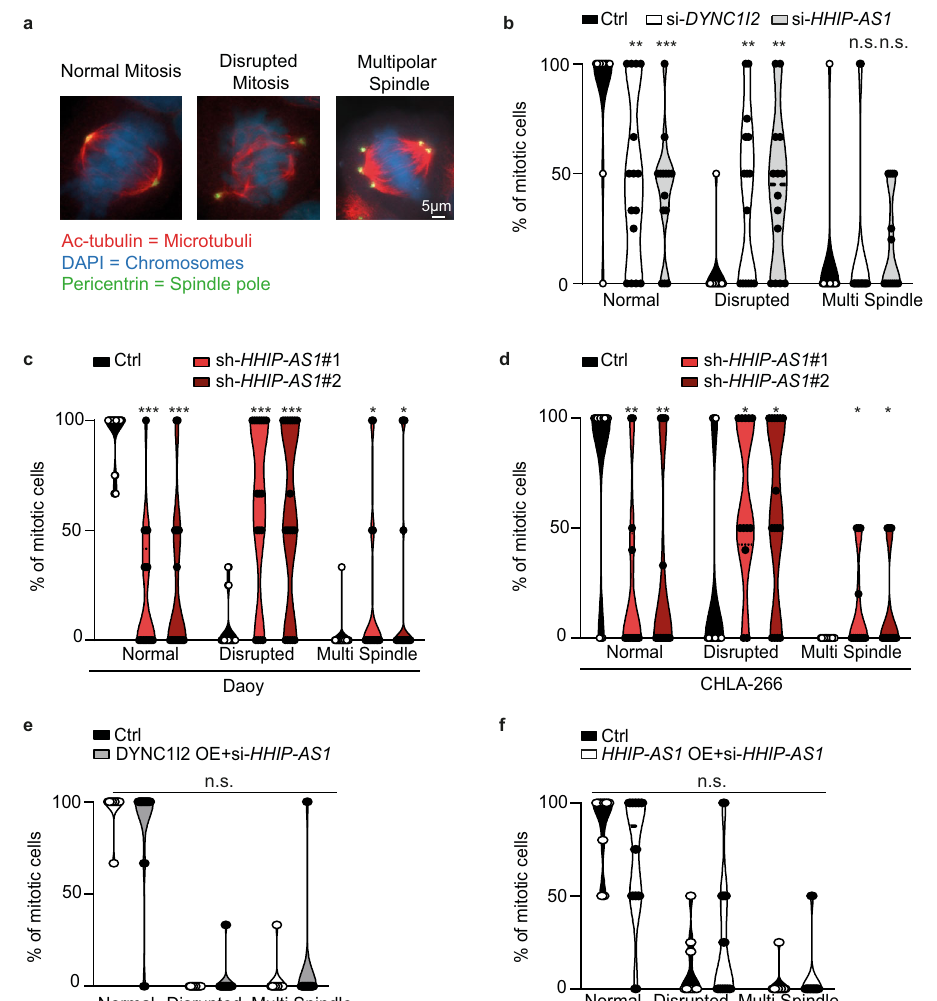
Fig. 4 The interaction between HHIP-AS1 and DYNC1I2 promotes mitosis. a Representative images of immuno fl uorescence analysis show spindle assembly in mitotic cells by immunostaining for acetylated tubulin (Ac-tubulin, red) and pericentrin (green). Chromosomes are visualized with DAPI (blue). White scale bar: 5 μ m. b – d Bar graphs display the percentage of dividing cells displaying normal, disrupted or multipolar spindle mitosis under control (Ctrl = si- negative -POOL or sh- scr ) condition and DYNC1I2 - or HHIP-AS1 -knockdown using siRNAs for transient knockdown in Daoy ( b ) or two independent shRNAs (sh- HHIP-AS1 #1 and sh- HHIP-AS1 #2) for stable HHIP-AS1 knockdown in Daoy ( c ) and in CHLA-266 ( d ). e Bar graphs showing the percentage of dividing cells displaying normal, disrupted or multipolar spindle mitosis under control (Ctrl) condition or upon rescue of DYNC1I2 expression by endogenous gene transcriptional activation through CRISPR-Cas9 technology in the context of transient HHIP-AS1 knockdown (DYNC1I2 OE + si- HHIP- AS1 ) in Daoy cells. f Bar graphs showing the percentage of dividing cells displaying normal, disrupted or multipolar spindle mitosis under control (Ctrl) condition or upon rescue of HHIP-AS1 expression by endogenous gene transcriptional activation through CRISPR-Cas9 technology in the context of transient HHIP-AS1 knockdown ( HHIP-AS1 OE + si- HHIP-AS1 ) in Daoy cells. All bar graph values are representative of n at least ten independent experiments (with a total n > 50 counted mitotic cells) and data are shown as mean ± SEM. Student ’ s two-sided t -test; *** p < 0.001; ** p < 0.01; * p < 0.05; n.s. not signi fi cant. Source data and exact p -values are provided as a “ Source Data fi le ”